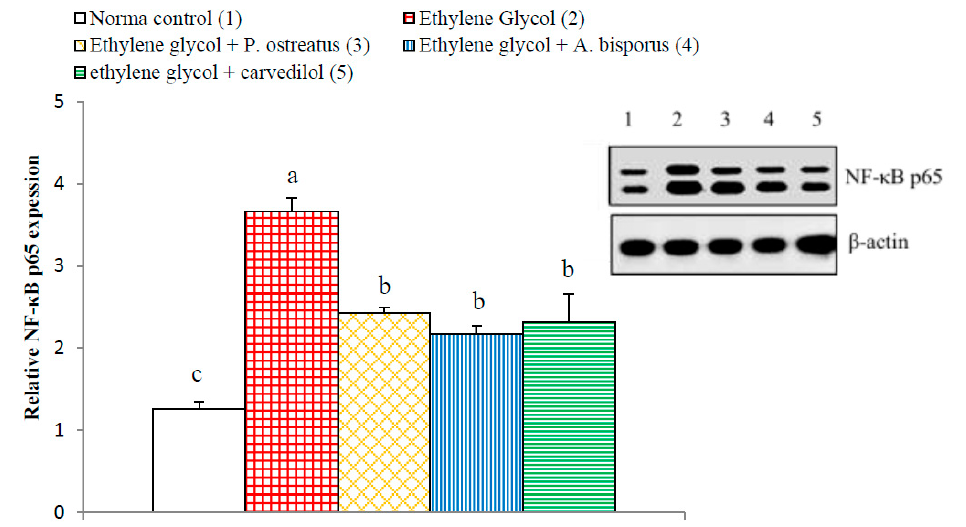
Figure 21. Effect of P. ostreatus and A. bisporus aqueous extracts and carvedilol on relative kidney NF- κ B p65 expression detected by Western blot in ethylene glycol-administered rats. Means which share the same letter(s) are not significantly different.